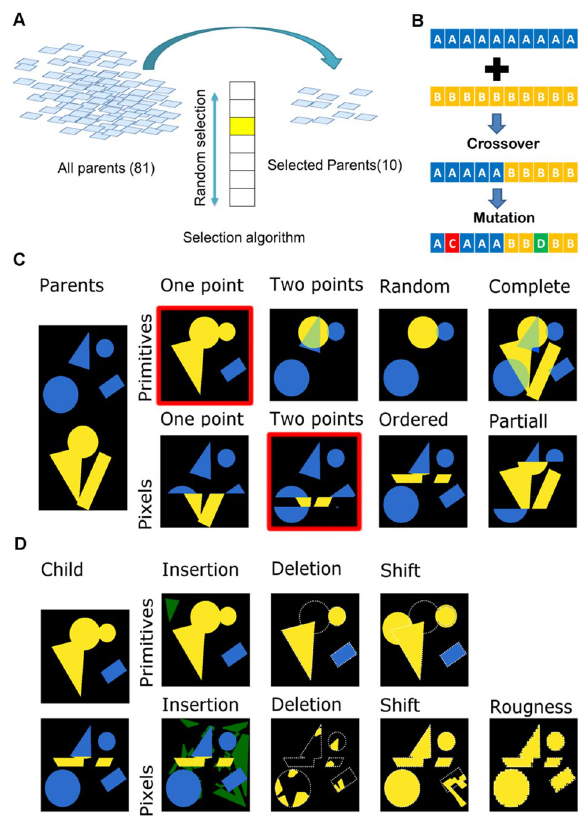
Figure 2. Selecting, recombining and mutating the genetic information of the parents. ( A ). Schematic representation of surface selection flow at the beginning of each cycle. ( B ) . Schematic representation of crossover and mutation algorithms. ( C ) Example of different crossover algorithms. Colours (yellow and blue) represent parts from different parents. Surfaces with red outline were selected further to demonstrate mutation algorithms. ( D ) Example of different mutation algorithms. Green regions correspond to newly-inserted elements of the design; white outlines corresponds to deleted